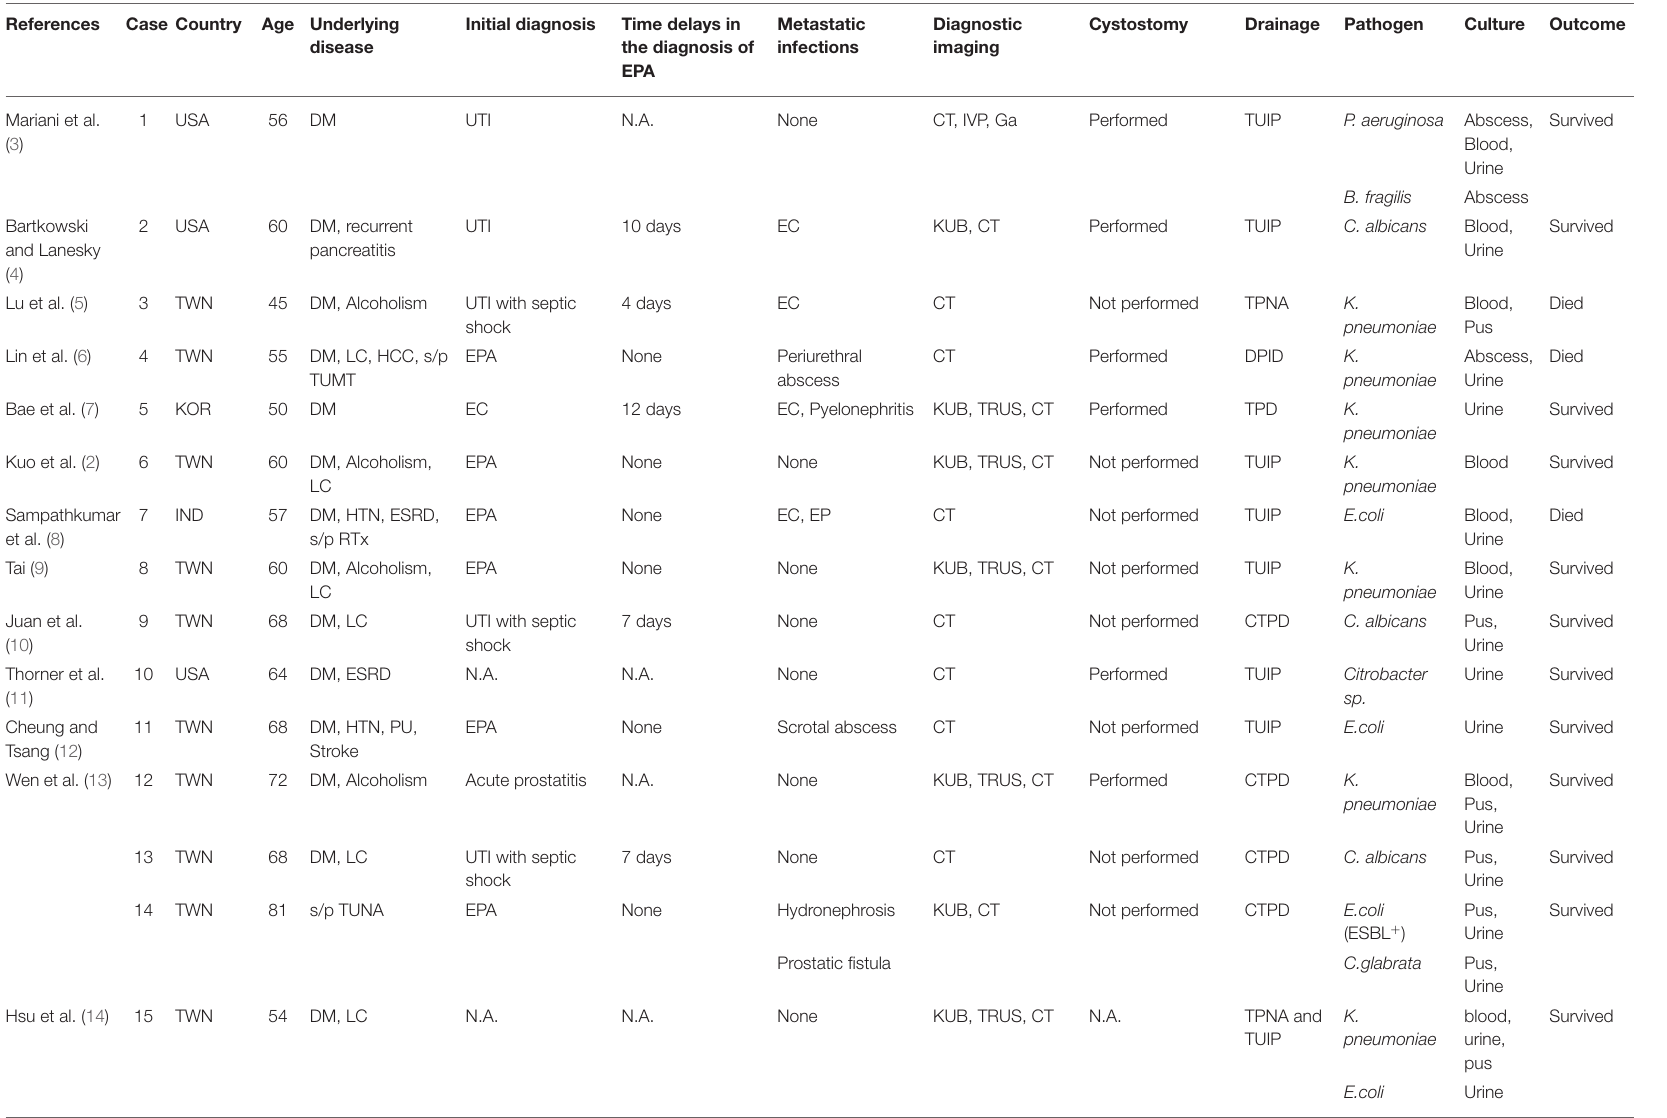
TABLE 1 | Cases of